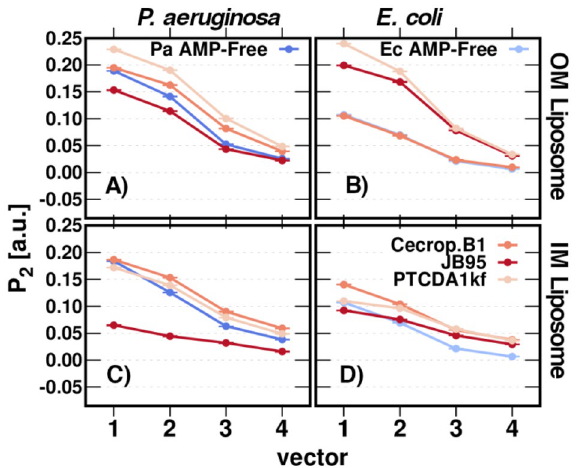
Figure 8. Order Parameter, P 2 . ( A – B ) P. aeruginosa and E. coli OM liposomes, respectively; ( C – D ) P. aeruginosa and E. coli IM liposomes, respectively. Analysis performed on the last μs of the MD production.